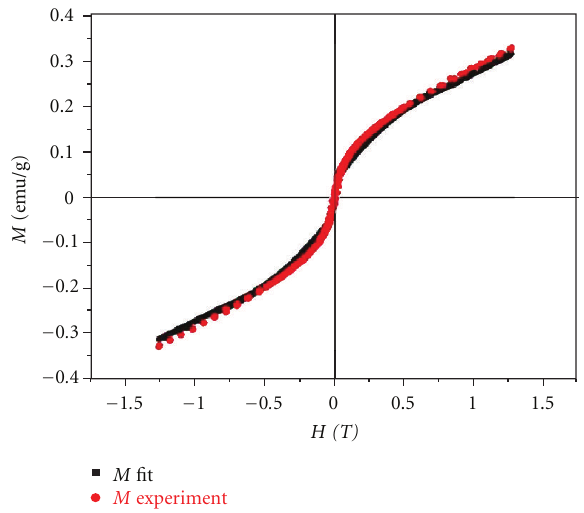
Figure 12: The result of the fitting of the M ( H ) curve of the nano-LaFeO 3 prepared by sol-gel method based on the Langevin